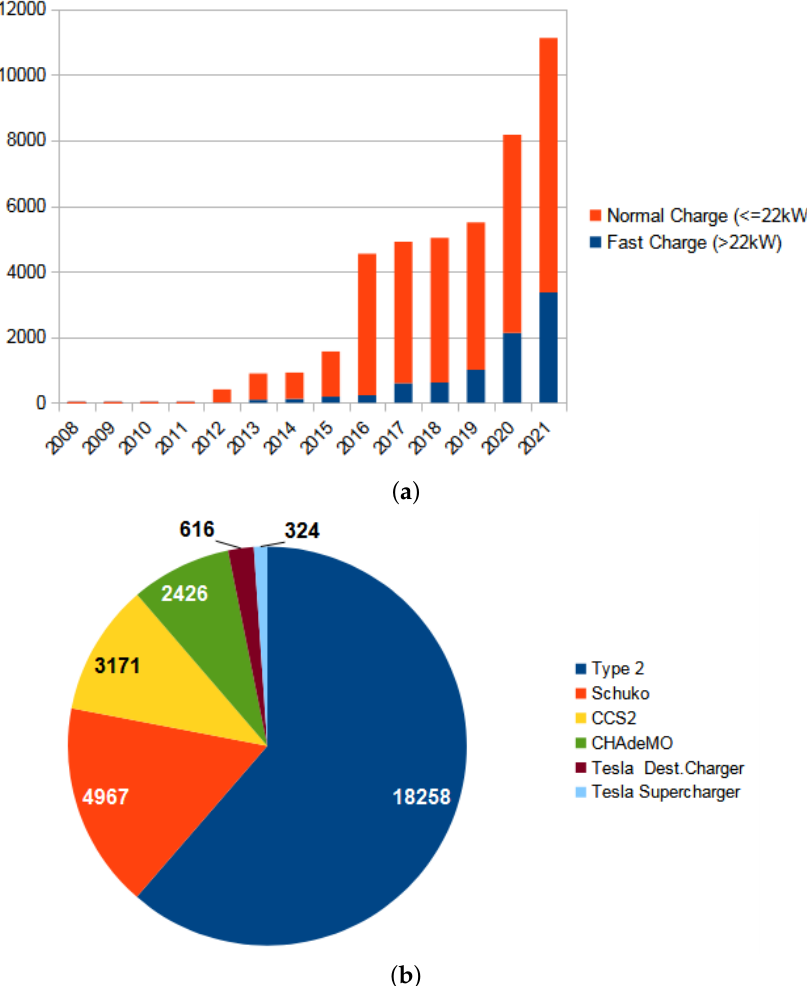
Figure 4. Evolution of charging infrastructure ( a ) and available sockets ( b ) in